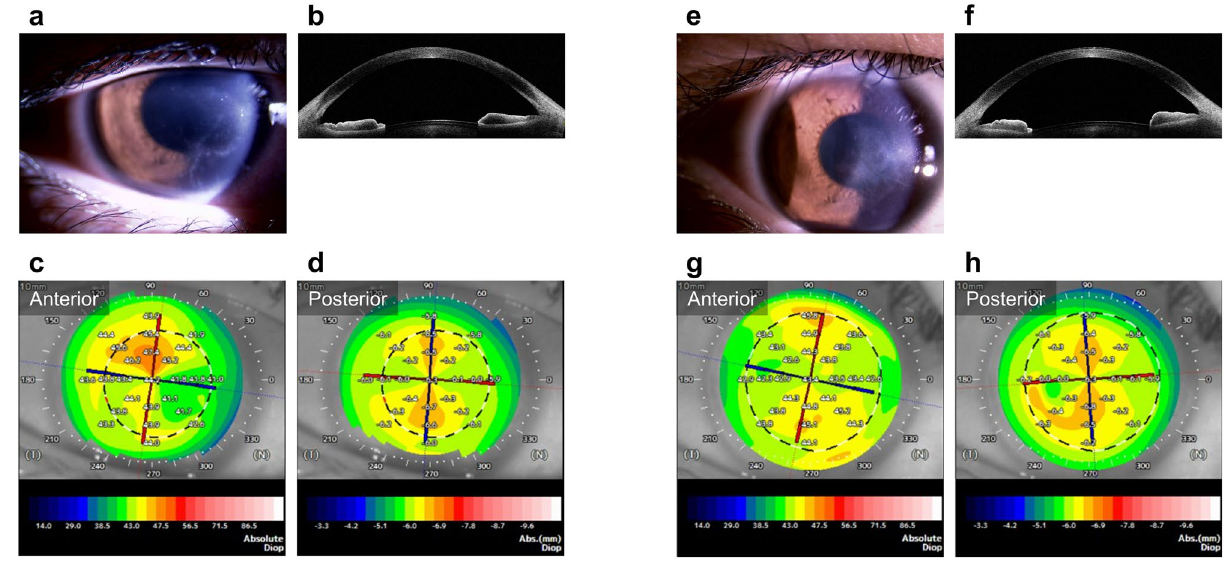
Figure 2. Slit-lamp and anterior segment optical coherence tomography images of a representative case of Acanthamoeba keratitis. ( a,b ) Before treatment, radial keratoneuritis is observed near the centre of the cornea to the nasal and inferior corneas. ( c,d ) The corneal higher-order aberration (HOA) (total, 6 mm) is 1.55 μm, and the logMAR best spectacle-corrected visual acuity (BSCVA) is 0.046. ( e–h ) The patient is treated with ophthalmic drops, and healed with corneal scarring. The corneal HOA (total, 6 mm) is 0.98 μm, and the logMAR BSCVA improved to − 0.08 after treatment, although a mild scar remains near the centre of the cornea.